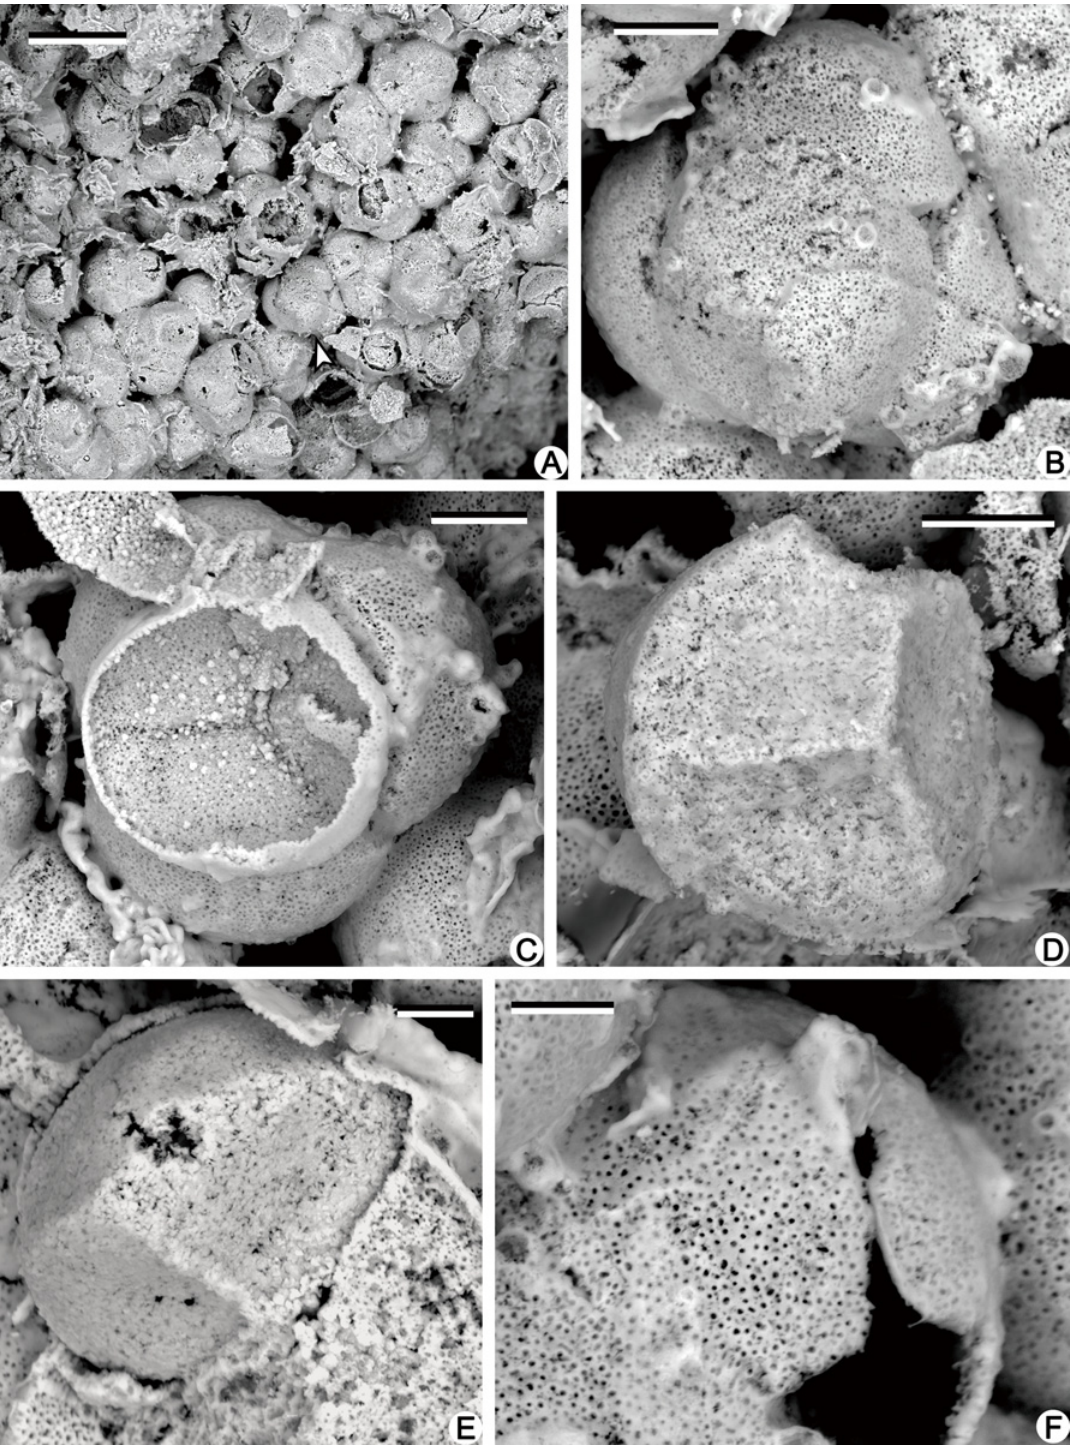
Fig 6. SEM observations of microspores of Minostrobus chaohuensis . (A) Tetrads of microspores. Arrow indicating portion enlarged in Fig. 6B. Scale bar = 50 μ m. (B) Enlargement of Fig. 6A (arrow), showing a tetrad with four visible microspores. Scale bar = 10 μ m. (C) A tetrad with one of the microspores broken in the distal face. Scale bar = 10 μ m. (D) A microspore showing the trilete and cingulum. Scale bar = 10 μ m. (E) A microspore showing the inner and outer exospores. Scale bar = 5 μ m. (F) Foveolate outer exospore of the microspore. Scale bar = 5 μ m.